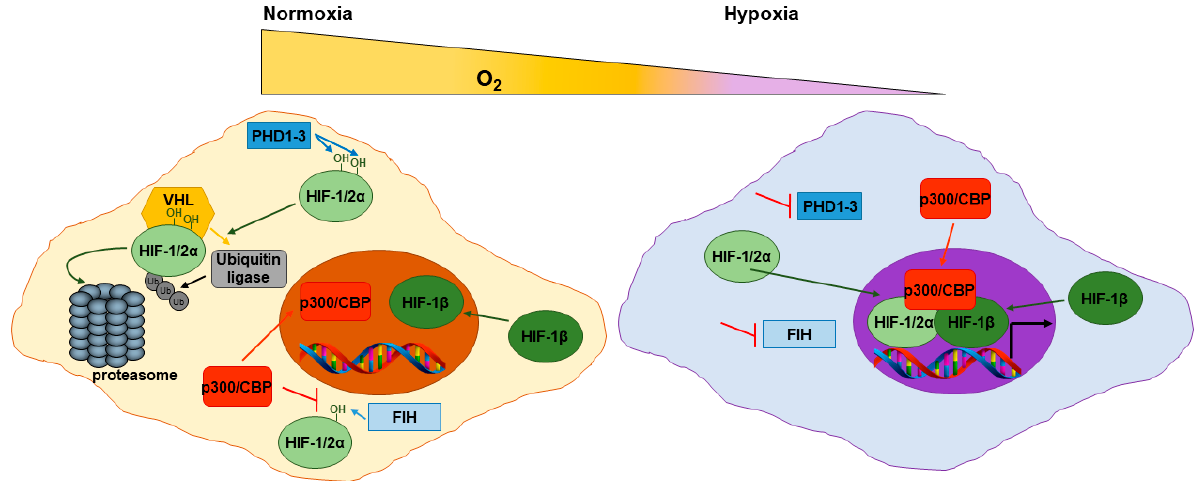
Figure 2. Regulation of HIF transcription factors. In normoxic cells, the PHD1-3 hydroxylate two prolyl residues within the HIF- α subunit enabling the binding of the VHL protein to the HIF- α subunit. VHL recruits E3 ubiquitin ligases that target HIF- α for degradation via the proteasome. In hypoxic cells, PHD1-3 activity (which is oxygen dependent) is inhibited. This leads to HIF- α stabilization and translocation to the nucleus where it binds to the HIF-1 β subunit and p300/CBP cofactors. HIFs bind to HRE within their target gene promoters. In normoxic cells, FIH hydroxylates an asparagine residue within the HIF- α subunit. This blocks the interaction between HIF and the transcriptional activators, p300/CBP.